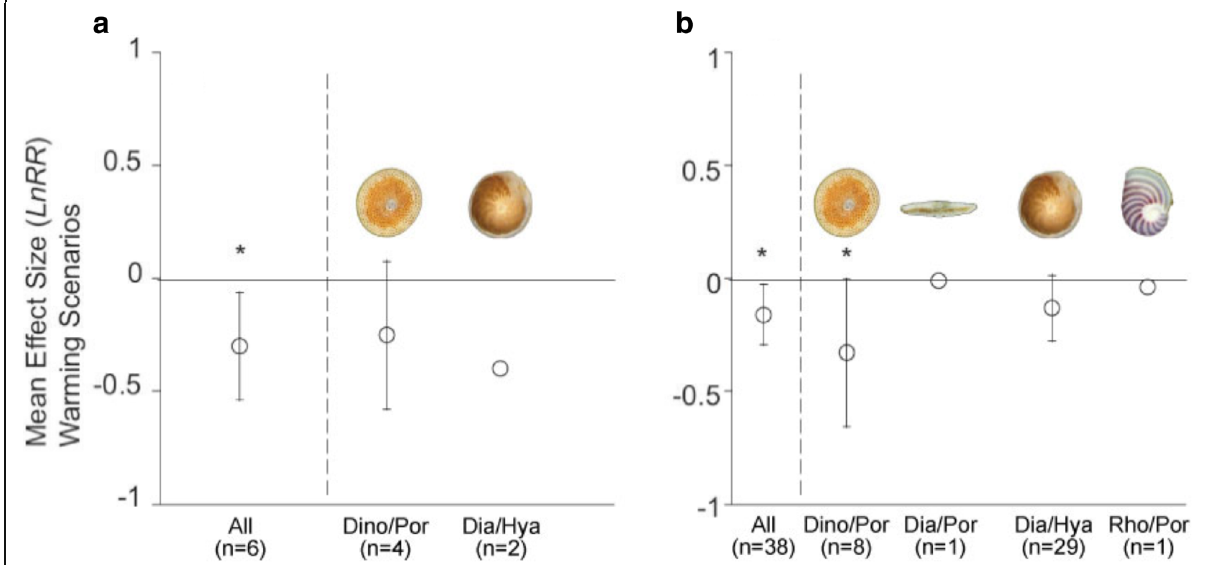
Fig. 8 Meta-analysis of the effects of ocean warming on the growth ( a ) and photosymbiont health ( b ) of algal symbiont-bearing large benthic foraminifera, performed by Doo et al. (2014) (the figure is modified from Doo et al. 2014). Eight publications on culturing experimental studies up to the year 2014 were compiled for this meta-analysis, using log-transformed response ratios (LnRR) comparing the present-day condition and a projected future scenario (Representative Concentration Pathway 8.5 from the Intergovernmental Panel on Climate Change, which projects changes of +4 °C by the year 2100; IPCC 2013). Negative LnRR values represent negative impacts, whereas positive values indicate positive responses. Circles indicate the mean value, with error bars indicating 95% confidence intervals. The variability within one group comes from data between different studies as well as those within the same study. The number of data combined per treatment (group) is shown in parentheses on the x -axis. An asterisk indicates a significant difference compared with the present-day condition. All all foraminifera, Dino / Por dinoflagellate symbiont-bearing porcelaneous foraminifera, Dia / Hya diatom symbiont-bearing hyaline foraminifera, Dia / Por diatom symbiont-bearing porcelaneous foraminifera, Rho / Por rhodophyte- bearing porcelaneous foraminifera. Foraminifera representative of each group are shown in the small